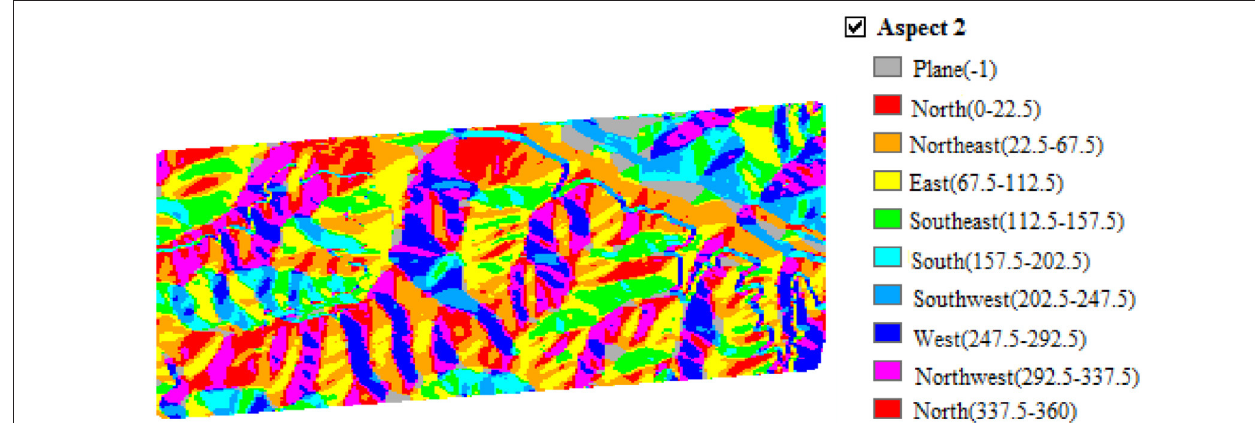
FIGURE 7 | Aspect.